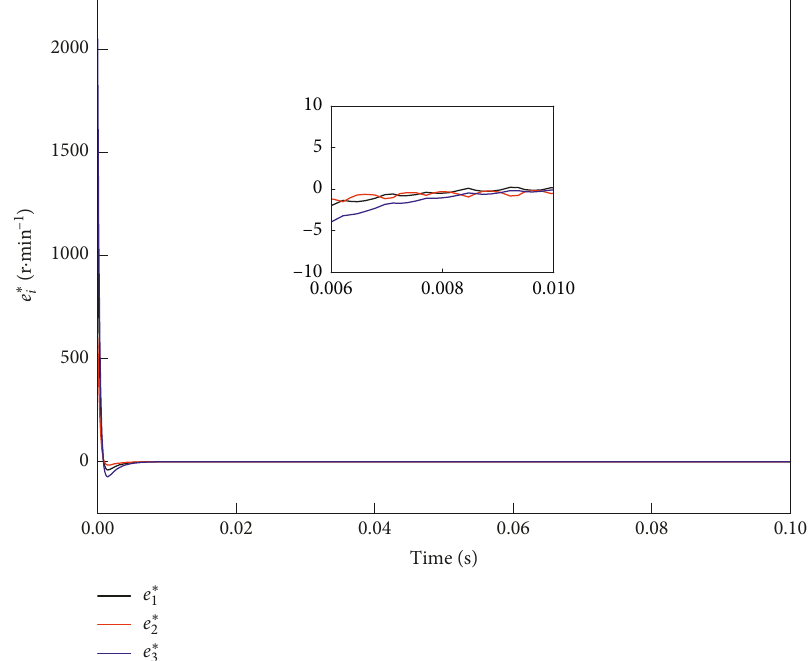
Figure 6: The velocity tracking error curves of all servos under the traditional PI